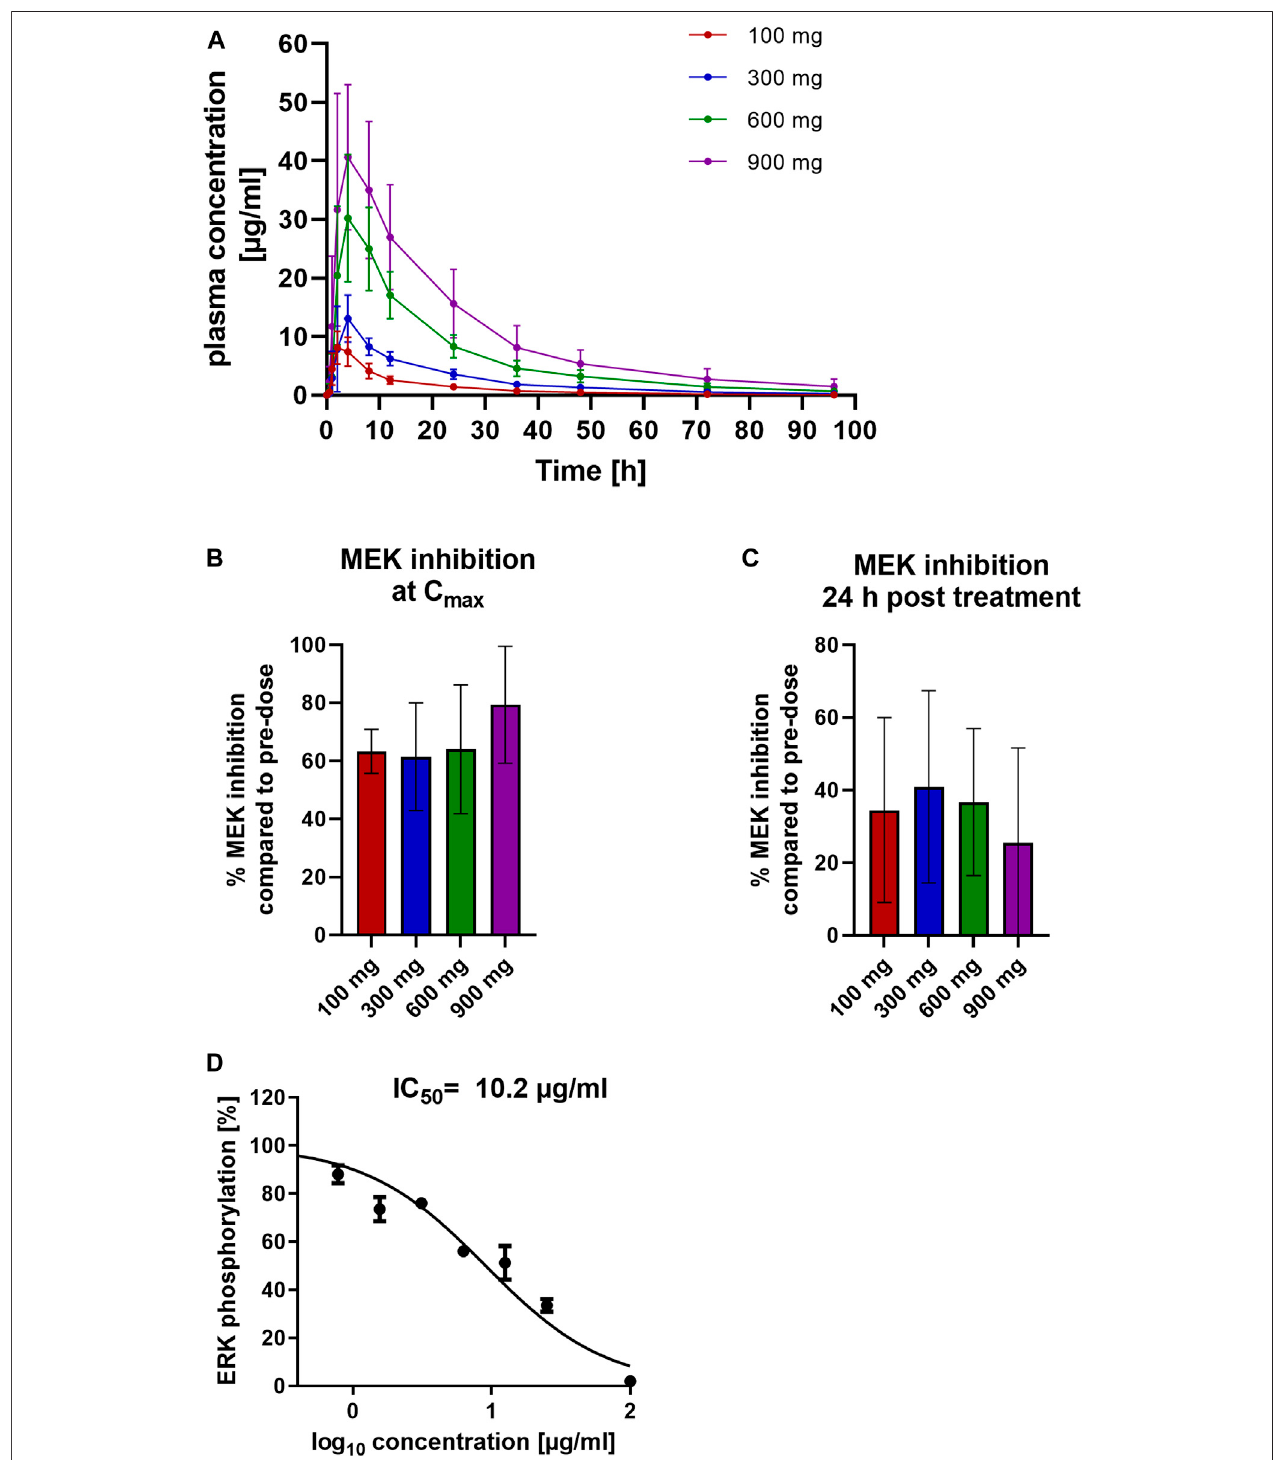
FIGURE 4 | Pharmacokinetic and pharmacodynamic assessment of zapnometinib in humans. Healthy volunteers were randomized to four cohorts for a single ascending dose in a phase 1 clinical trial and were treated with either 100, 300, 600 or 900 mg zapnometinib. Blood was taken 0.5, 1, 2, 4, 8, 12,and24 hlaterand analyzedforplasmaconcentrationandMEKinhibition.Additionally,bloodwastakenat36,48,72,and96 haftertreatmentfortheMADpart. (A) Plasmaconcentrationsfollowinga singledoseof100,300,600and900 mgzapnometinib.Dataarepresentedasmean±SD( n =8). (B) MeanMEKinhibitionatC max comparedtopre-doseanalyzedbyERK phosphorylationwithWes TM inPBMCsatthehighestzapnometinibplasmaconcentration(C max, t =2 – 4 h; n (100 mg) =7; n (300 mg) =7; n (600 mg) =6; n (900 mg) =5)and( C )24 hpost